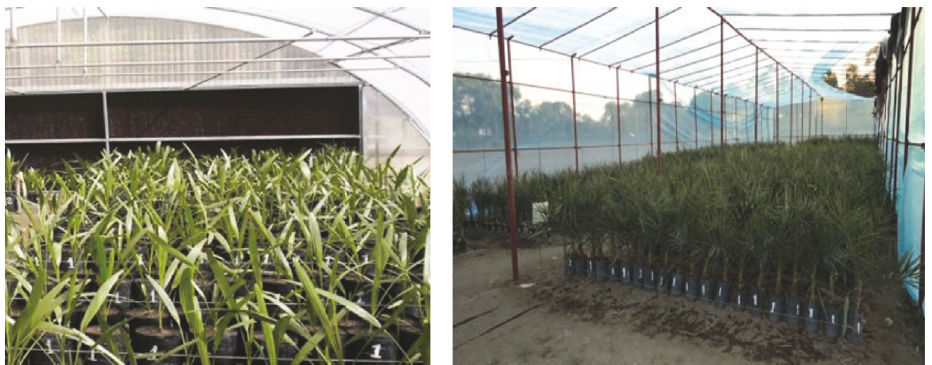
Figure 3: Propagation nursery for tissue cultured and improved date palm varieties in Werer Agricultural Research Center (Photos taken during field observation, 2016).